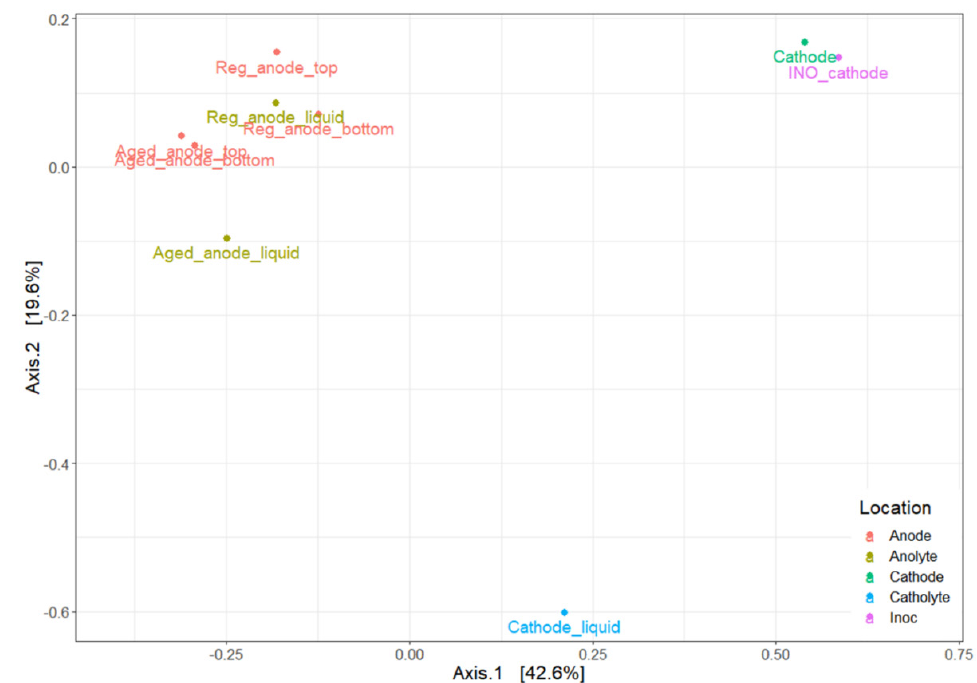
Figure 11. Bray-Curtis dissimilarity of a sequenced sample. Sampling locations were indicated with “top” (top of the electrode), “bottom” (bottom of the electrode), or “liquid” (electrolyte sample). “Aged” or regenerated anode samples were indicated with “Aged” or “Reg”.